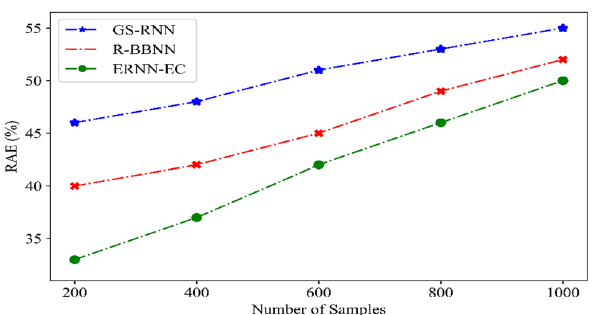
Figure 7: Comparison of RAE.